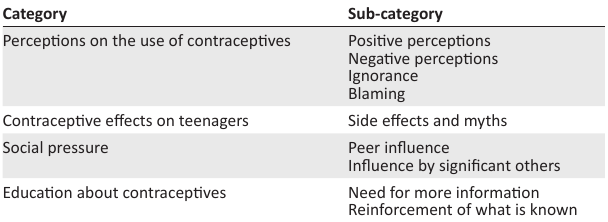
TABLE 1: Categories and subcategories on the perceptions of female teenagers on the use of contraceptives.